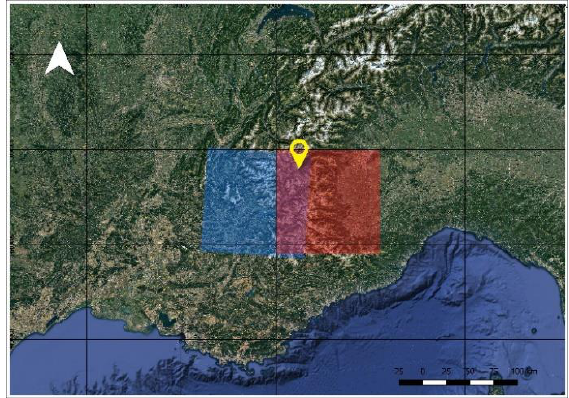
Figure 1. Study area. The Blue square covers the K tile, while the red one covers the Q tile. The yellow pointer indicates Cesana Torinese (TO).